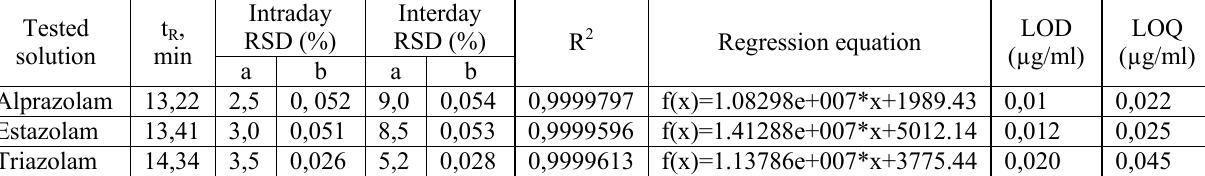
Fig. 5. Reference mixture solution (RS MAET2) chromatogram: RS A2 – Alprazolam (retention time 13.216 min.), RS E2 – Estazolam (13.407 min.), RS T2 – Triazolam (14,340 min.) Analytical characteristics of HPLC method validation